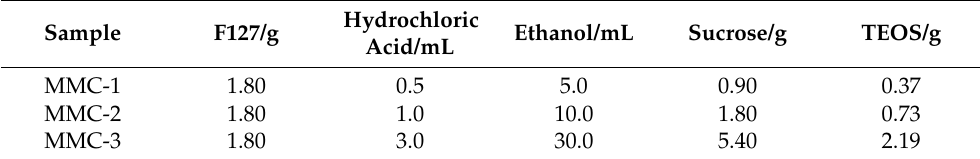
Scheme 1. Synthesis of MMC and MOMMC. Table 1. Detailed recipes for the prepared micro/mesoporous carbon